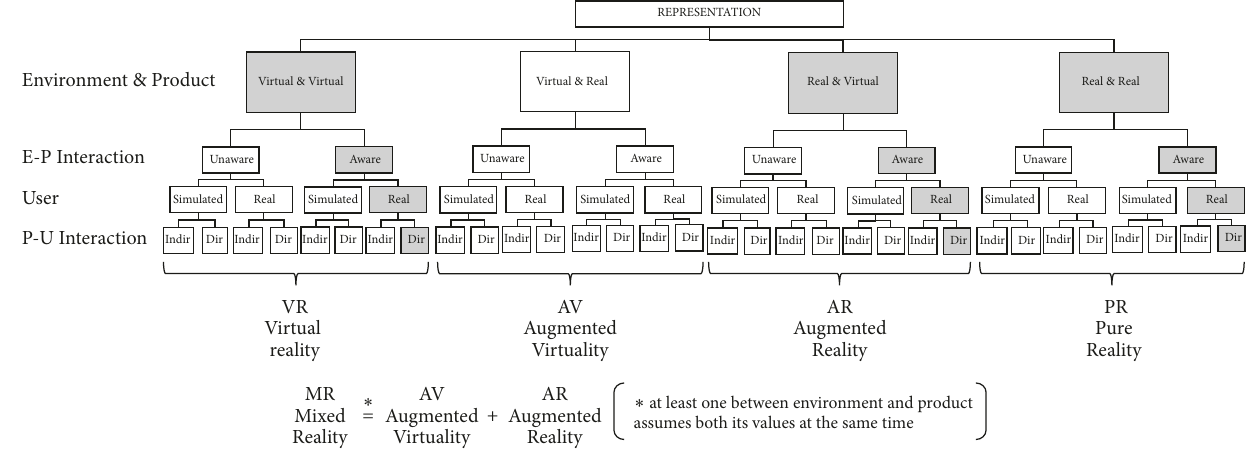
Figure 1: Classification of